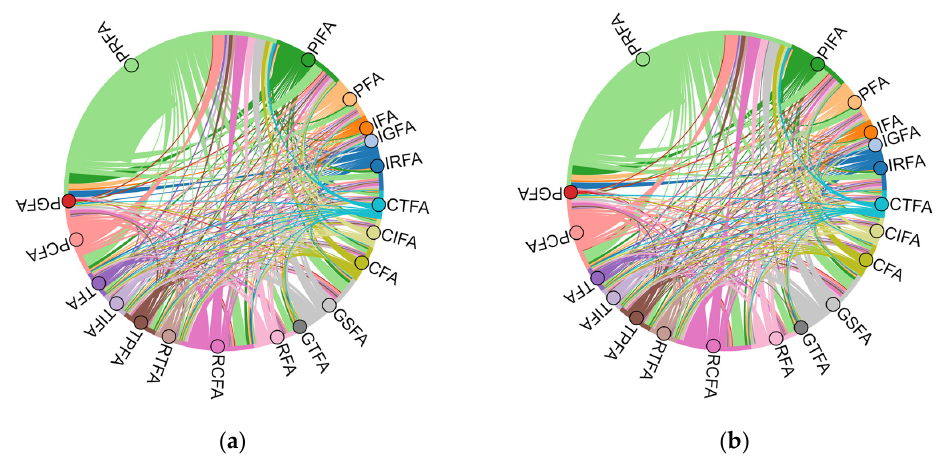
Figure 7. The taxi flow interaction between different UFA types: ( a ) Chord gram on weekdays; ( b ) chord gram on weekends.